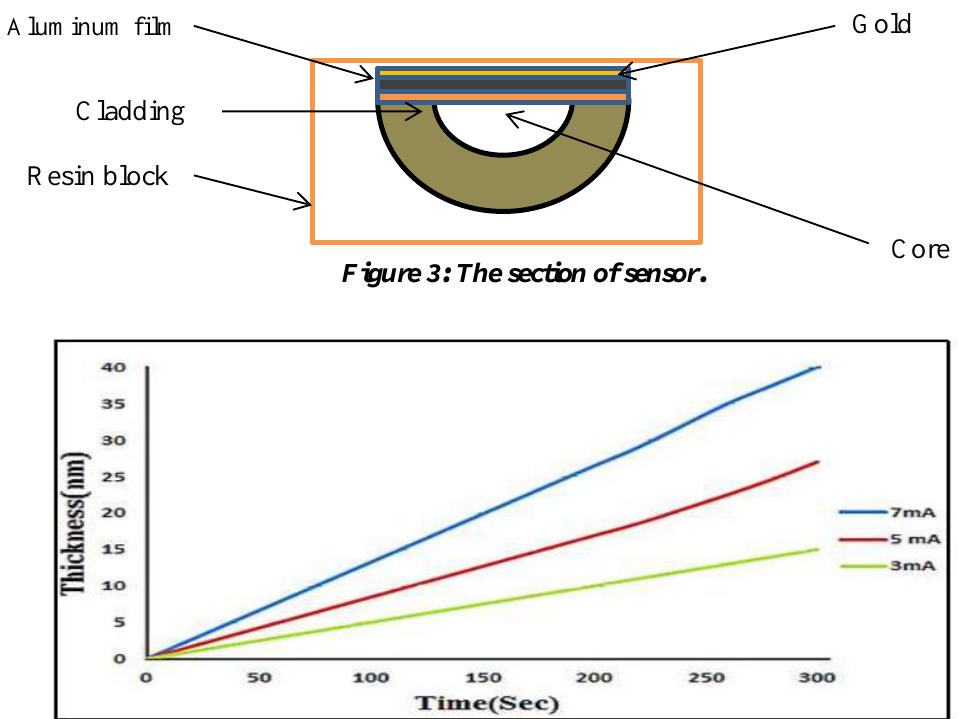
Figure 4: The thickness of the gold layer as a function of deposition time in